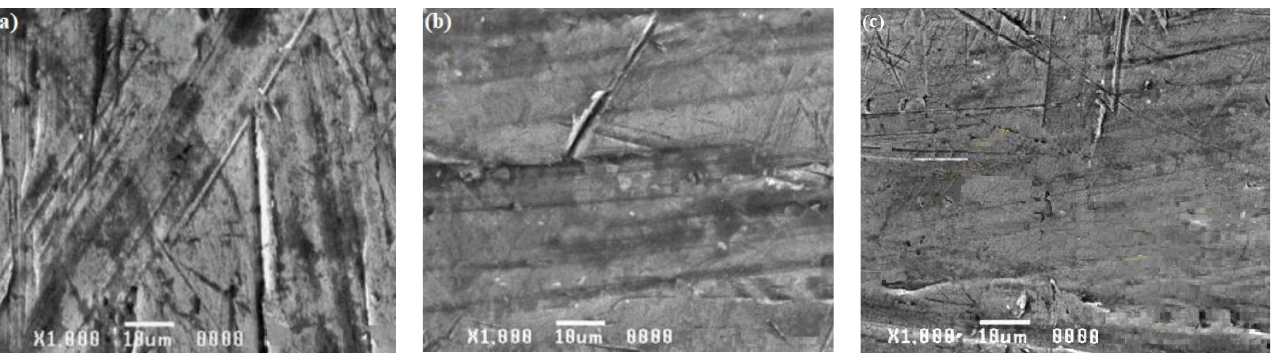
Figure 12. SEM images of ( a ) AA6061, ( b ) AA8011, and ( c ) weld region specimens after submersion testing in seawater.